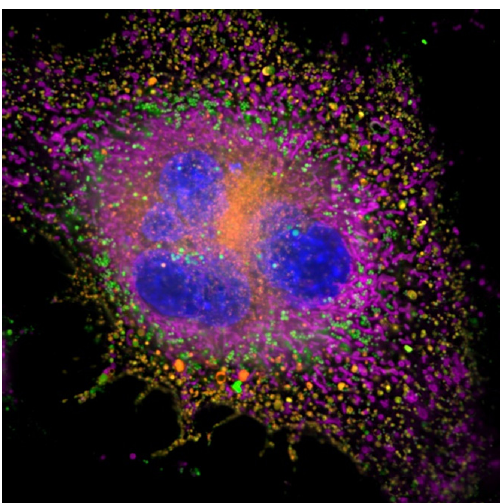
Figure 3. Subcellular localization of 4b . Live-cell imaging of SK-MEL-28 cells after 12 h incubation with 1 µM 4b . Intravital staining was used to label mitochondria (pink), nuclei (blue) and endoly- sosomal compartments (red). Compound 4b displays its intrinsic fluorescence (green) and is localized to lysosomes (orange spots—colocalization with red probe for lysosomes) and adiposomes (lipid droplets); green—no colocalization with any applied organelle-specific probes). For further data from subcellular localization, see Figures S16–S19.